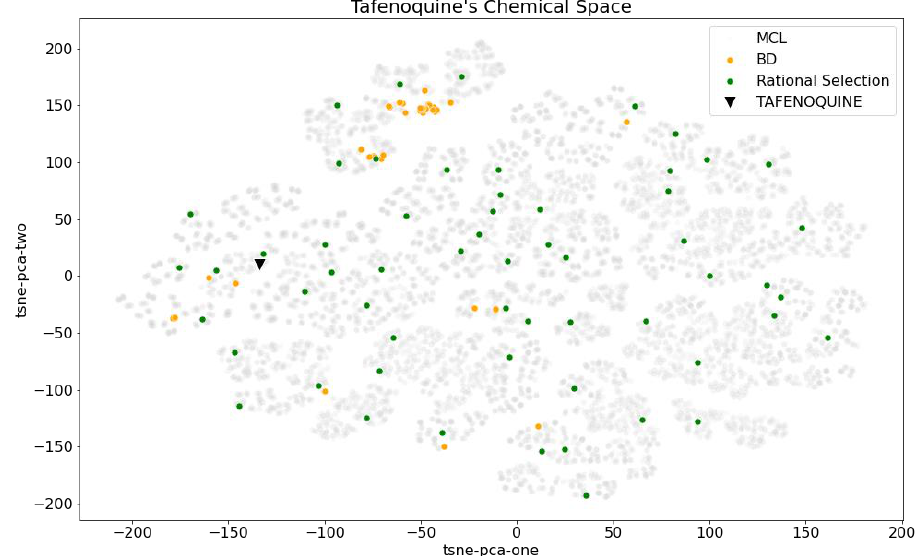
Figure 4. t -SNE representation of Tafenoquine’s chemical space, depicting the MCL compounds (grey), BD subset (orange), compounds selected by the rational selection of N BD analogs (green) and the original hit (black triangle).